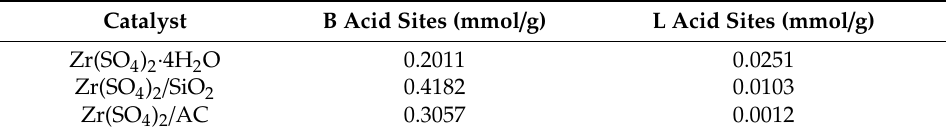
Figure 3. Figure 3. Pyridine-adsorbed IR spectra of ( 1 ) Zr(SO 4 ) 2 ∙ 4H 2 O, ( 2 ) Zr(SO 4 ) 2 /SiO 2 , and ( 3 ) Zr(SO 4 ) 2 /AC catalysts. Table 2. Concentrations of B and L acid sites on prepared Table 2. Concentrations of B and L acid sites on prepared catalysts.